Question: Briefly state, in one sentence, what is plotted here.
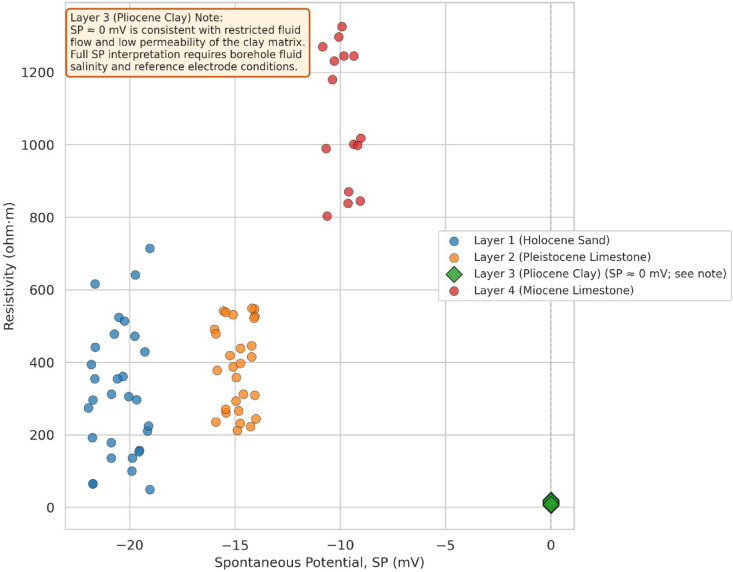
Answer: Scatter plot of spontaneous potential (SP, mV) versus electrical resistivity (ohm·m) for all four geoelectrical layers ( n = 87 borehole–ERT stations; Ras El-Hekma). Data points are colour-coded by layer; Layer 3 (Pliocene Clay) is plotted as diamond markers to highlight its distinctive SP signature. The dashed vertical line at SP = 0 mV serves as a reference. Layer 1 (Holocene Sand) exhibits moderately negative SP values (− 19 to − 22 mV) associated with permeable, sand-dominated matrix. Layer 2 (Pleistocene Limestone) shows SP values of − 14 to − 16 mV, reflecting intermediate permeability. Layer 4 (Miocene Limestone) displays SP values of − 9 to − 11 mV, consistent with moderate fluid mobility in a fractured carbonate. Layer 3 (Pliocene Clay) records SP ≈ 0 mV, which is consistent with restricted electrochemical activity and low permeability of the clay-rich matrix; however, definitive SP interpretation for this layer requires additional electrochemical context, including borehole fluid salinity and reference electrode calibration conditions, and should not be taken alone as confirmation of aquitard status. Produced using Python (Https://matplotlib.org/; https://seaborn.pydata.org/tutorial/function_overview.html).